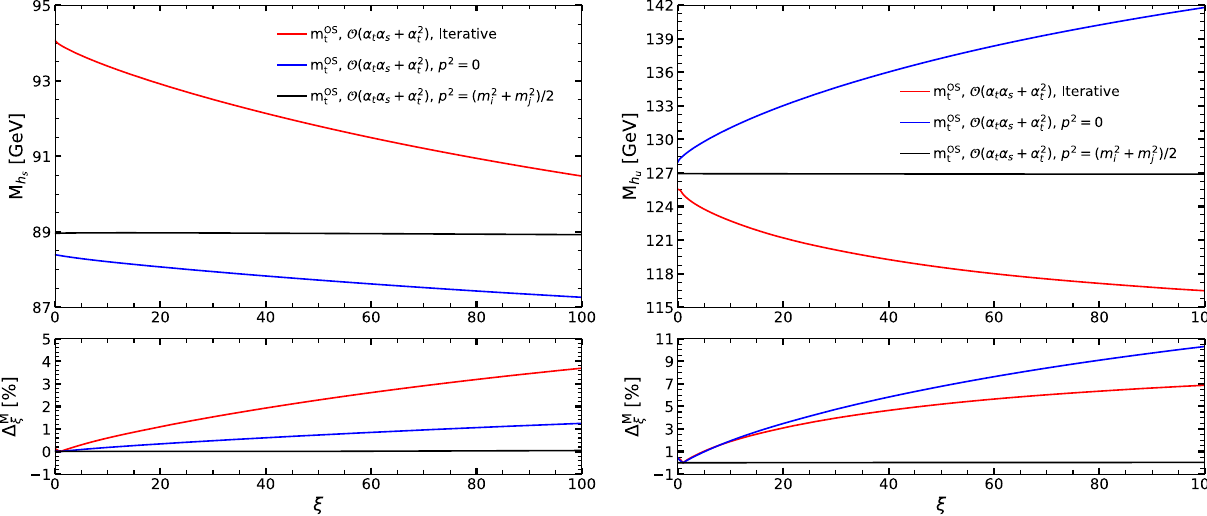
Fig. 7 Upper panel: The CP-even singlet-like (left) and the h u -like (right) Higgs boson masses at two-loop O (α t α s + α 2 t ) level in the OS scheme of the top/stop sector applying the iterative (red), the R 0 - (blue)